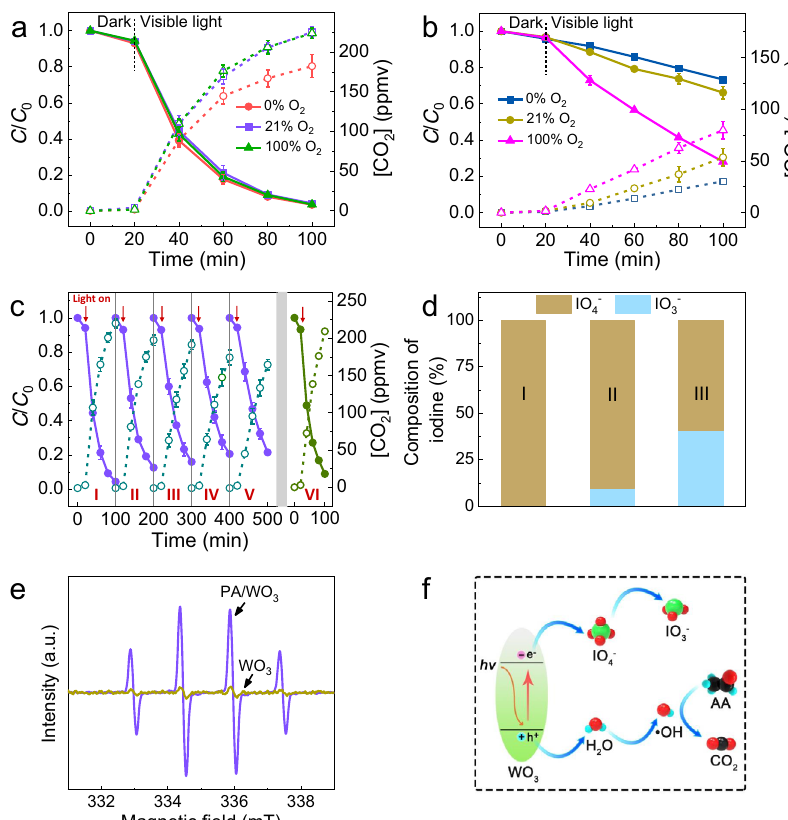
Fig. 5 Effects of O 2 and PA. Effect of O 2 concentration on the PCD of acetaldehyde (AA) over a PA/WO 3 and b bare WO 3 . c Repeated PCD cycles of AA degradation and the concurrent production of CO 2 over PA/WO 3 (I, 1st cycle; II, 2nd cycle; III, 3rd cycle; IV, 4th cycle; V, 5th cycle), (VI) PA/WO 3 was regenerated after 5th cycle. Error bars are de fi ned as standard deviation. d Relative distribution of iodine species in (I) fresh PA/WO 3 , PA/WO 3 used after (II) 1st PCD cycle and (III) 5th PCD cycle of AA degradation in c : IO 4 − (brown) and IO 3 − (cyan). e EPR spectra probing the photogeneration of (cid:129) OH adduct ( (cid:129) OH-DMPO) in an aqueous catalyst slurry containing DMPO ( C 0 = 10 mM). f Proposed PCD mechanism of AA. The dashed lines with open symbols represent the CO 2 concentration generated from AA degradation. Experimental conditions: [AA] 0 = 120 ppmv; visible light ( λ > 420 nm) intensity of 2.2 mW/cm 2 ; sample amount of 50 mg; RH 65%; reaction temperature of 30